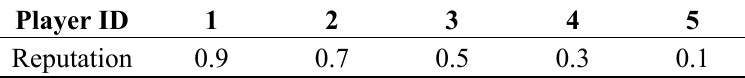
Table 2. Reputation of the competitor players.